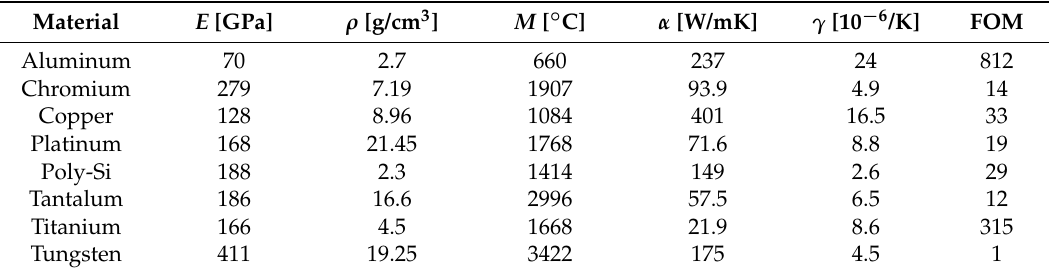
Table 1. Properties of some common materials used in microfabrication considered as potential candidates for the MOPFET electrodes. Tungsten is the material of choice due to its low FOM. Experimentally, copper also worked well because of its high thermal conductivity